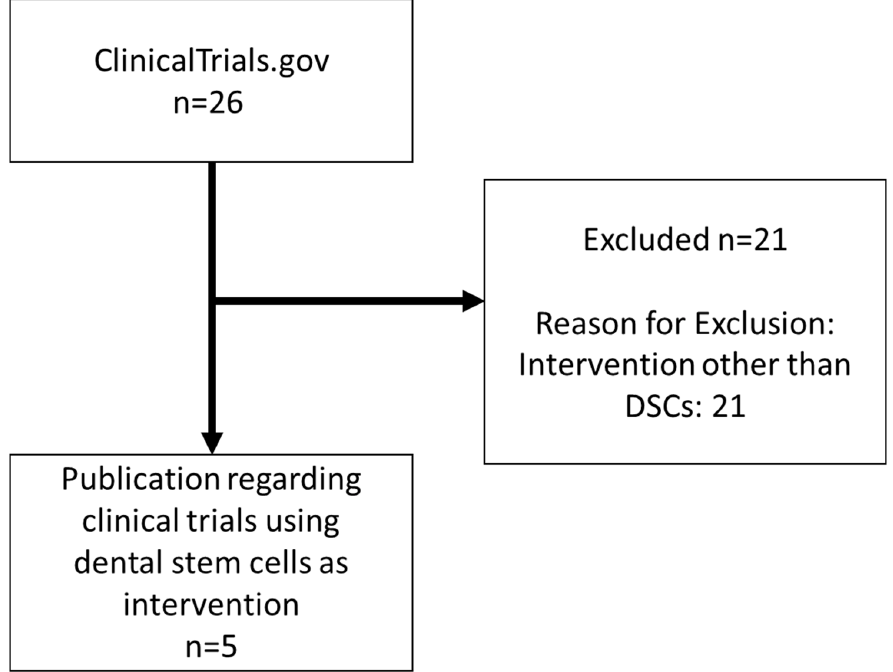
Figure 8. Systematic review flow chart of the systemic ClinicalTrials.gov database review. Out of the 26 currently active clinical trials, 21 trials had to be excluded, since they did not use dental stem cells for intervention, leaving a total of five clinical trials where DSCs were used as intervention.